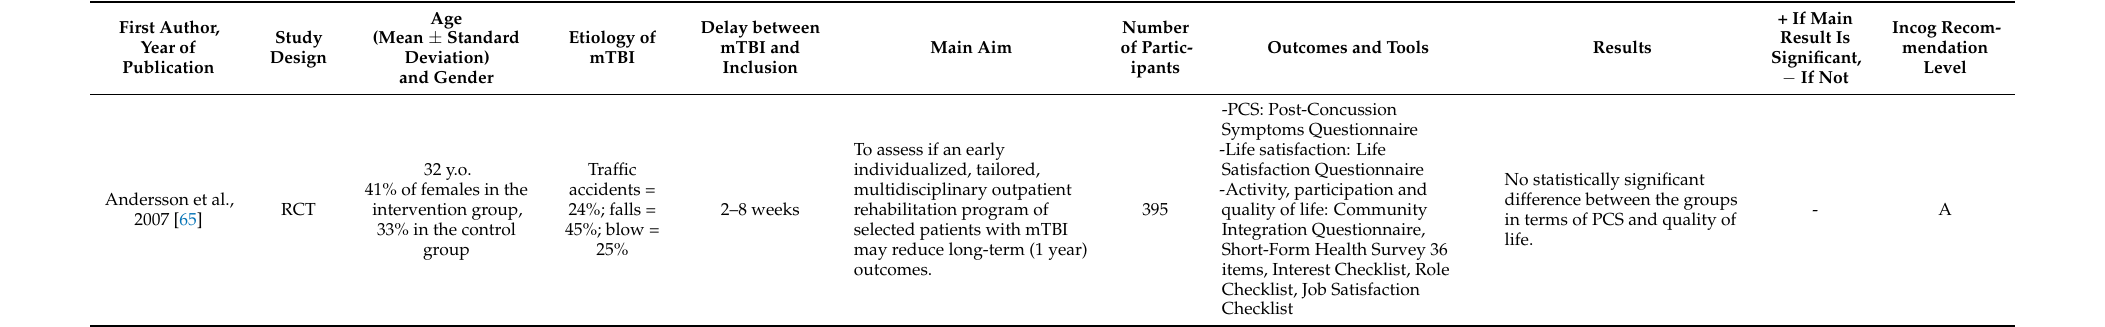
Table A4. Early interventions (18